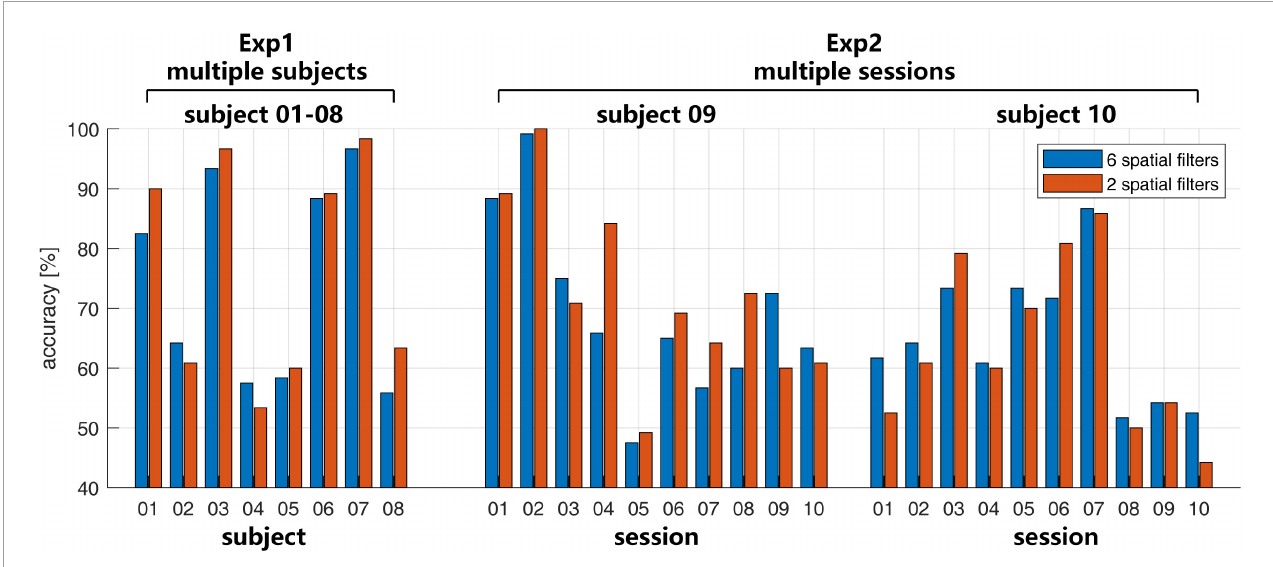
FIGURE3 The recognition accuracies with the number of spatial filters 6 (blue bar) and 2 (red bar) in Exp1 and Exp2.